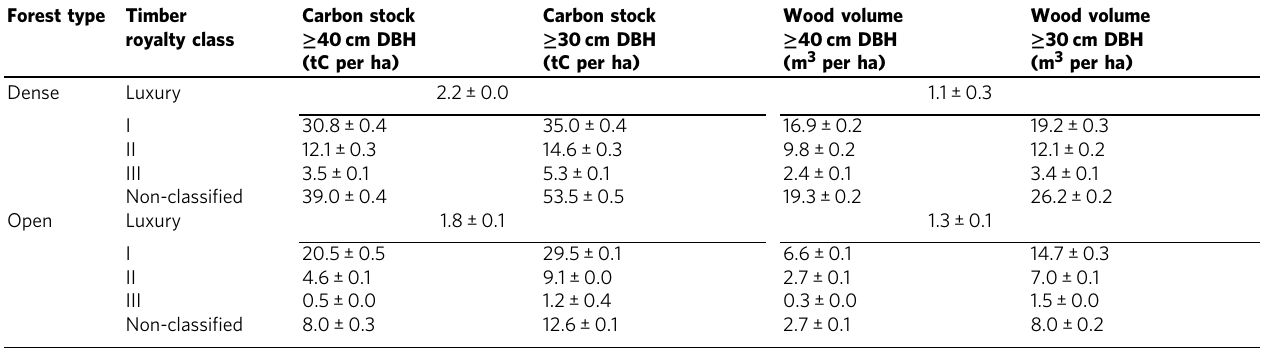
Table 1 Mean carbon stock and wood volume held in harvestable stems of each timber royalty class in dense and open forests Forest type Timber royalty